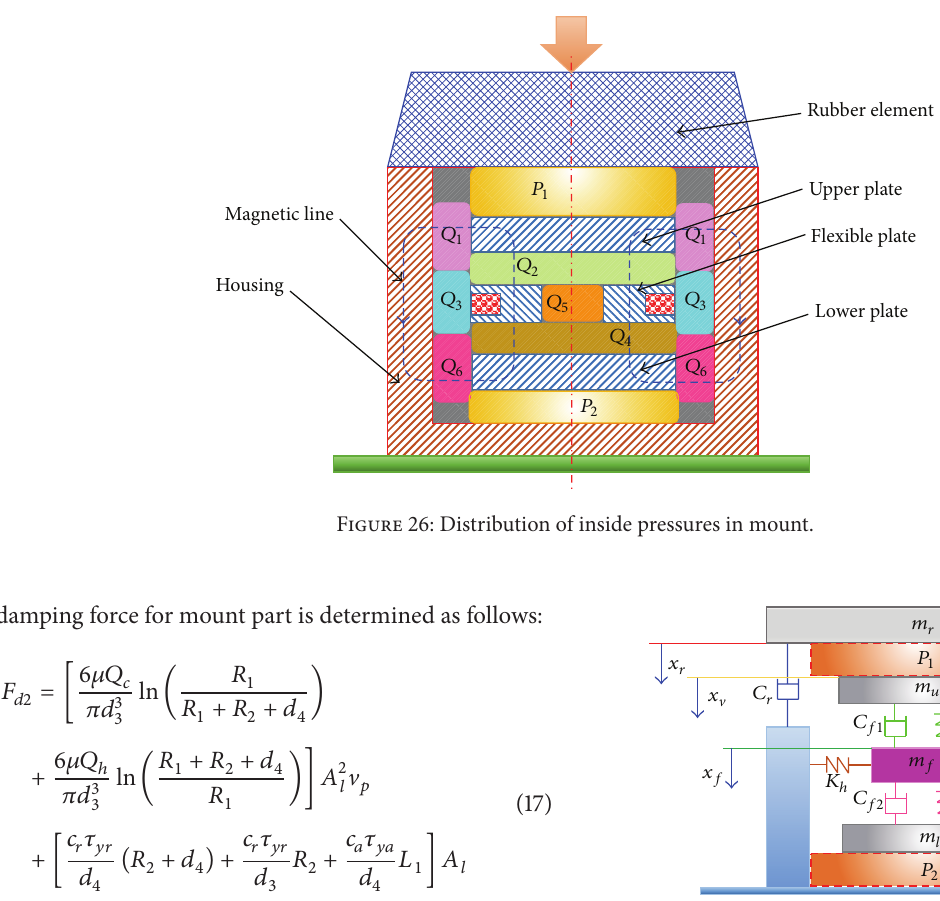
Figure 27: Mechanical model of MR